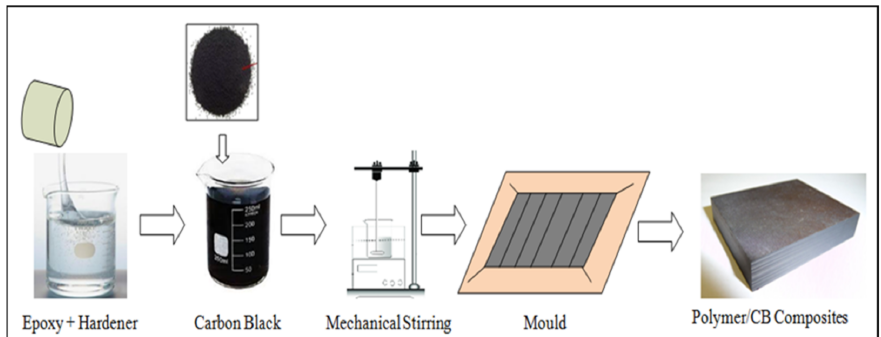
Figure 18. Synthesis of polymer–CB